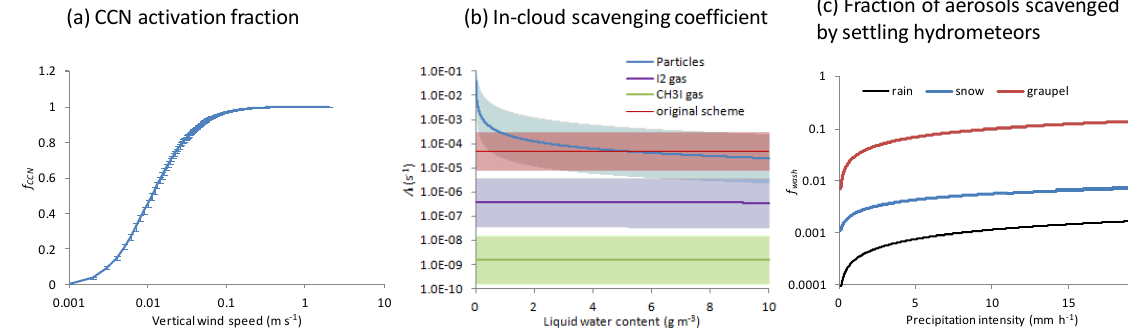
Figure A2. (a) Changes in the CCN activation fraction, f ccn , versus the vertical wind speed, (b) in the modeled in-cloud scavenging coefficient, (cid:51) , of gaseous and particulate radioactive substances versus the vertical mean liquid water content, W L in Eq. (A7), and (c) in the modeled fraction of aerosols scavenged by settling hydrometeors ( f wash ) for rain, snow, and graupel versus the precipitation rate. Input meteorological data are mainly from the surface weather stations in Ibaraki and Fukushima Prefectures from 12 to 15 March, 2011 and show the following: 5 ◦ C for air temperature and 950hPa for air pressure in (a) and (c) , and 15 ◦ C for air temperature, 1km for cloud thickness, 1mmh − 1 for precipitation rate with f ccn , f ice , and f qc =1 in (b) . The vertical bars in (a) show the deviation in f ccn when air temperature and pressure were changed from 0 to 15 ◦ C and 900 to 1000hPa, respectively. The shaded areas in (b) represent the range of (cid:51) when precipitation rate changes from 0.1 to 10mmh − 1